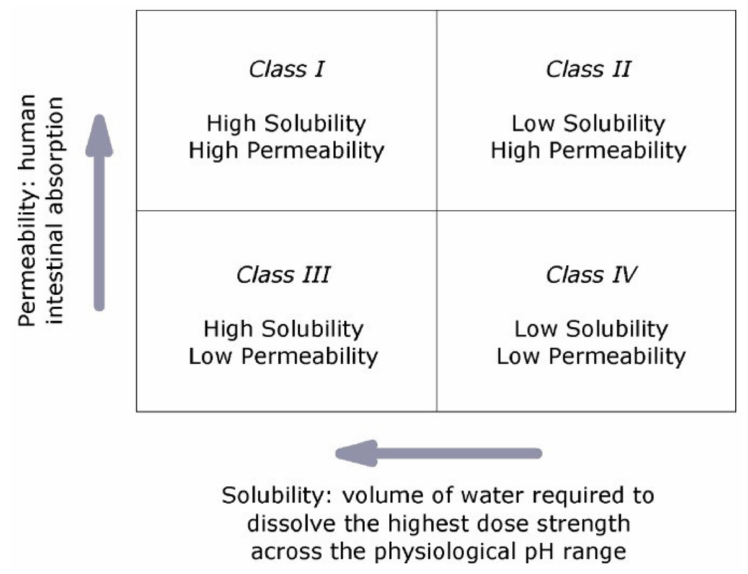
Figure 2. BCS Classification of drugs.